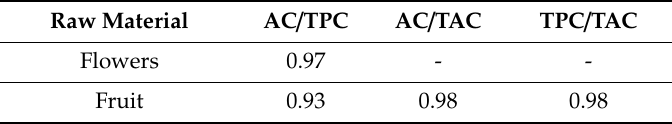
Table 4. Pearson correlation coefficients between each pair of antioxidant activity (AC) and total